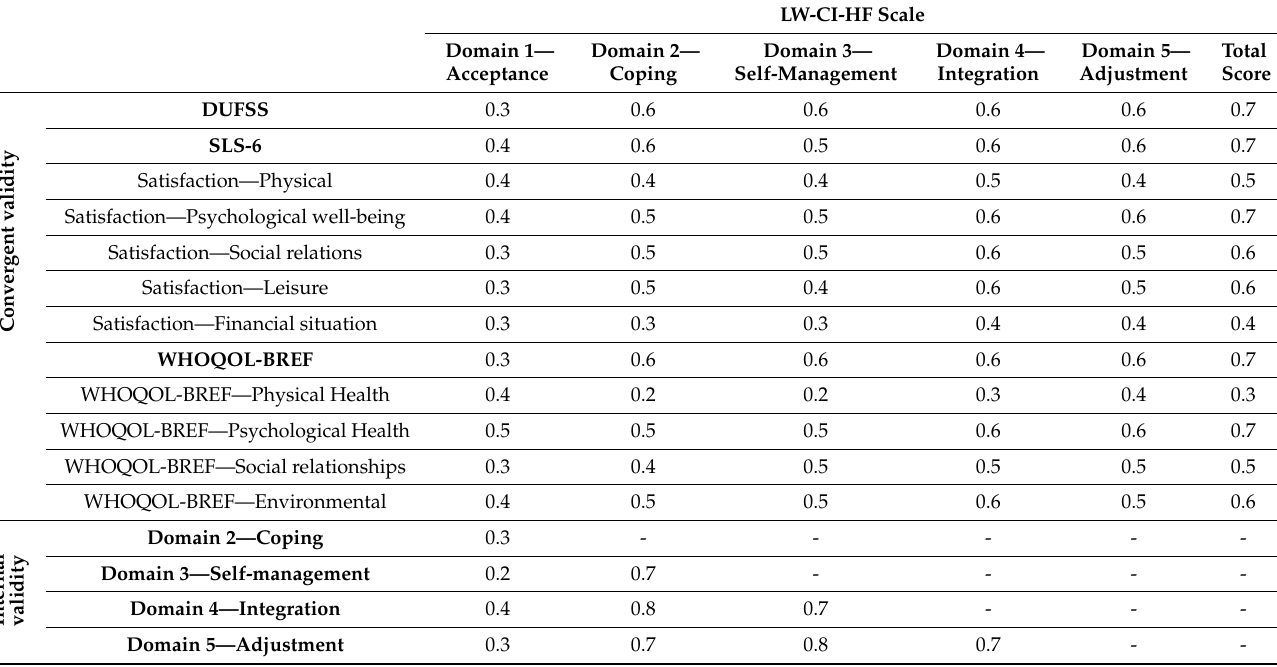
Table 3. Convergent validity and internal validity of LW-CI-HF